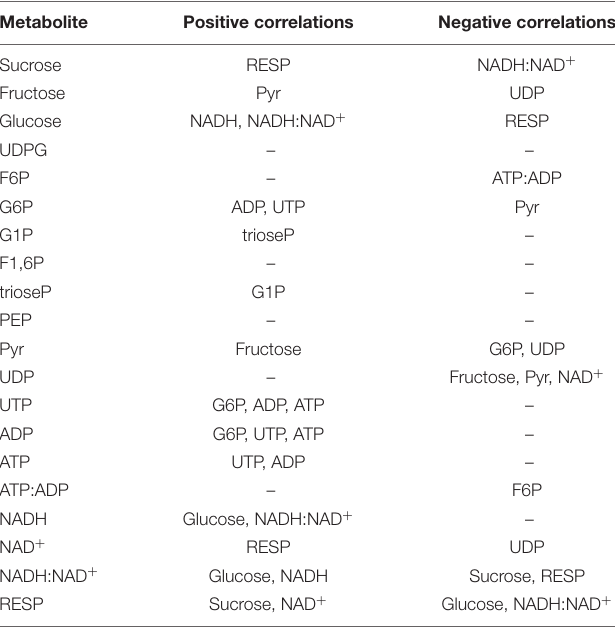
TABLE 4 | Significant correlations between glycolytic pathway metabolites, ATP:ADP ratio, NADH:NAD + ratio, and respiration rate (RESP) in roots during 60 days storage.